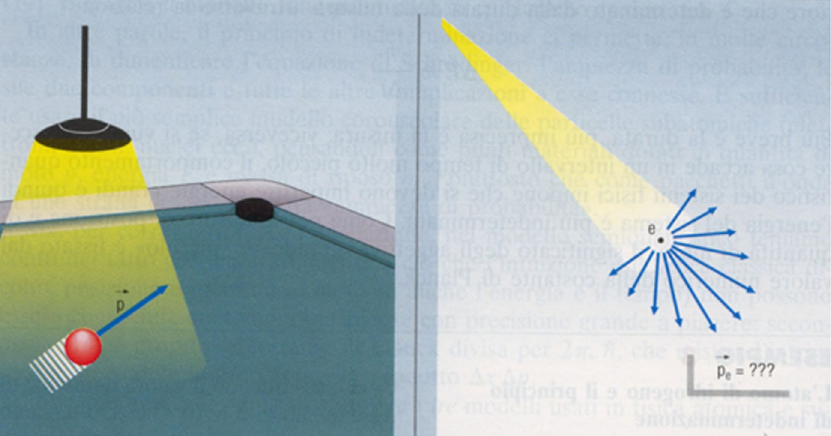
FIG. 6. Depiction of the uncertainty principle from the Heisenberg microscope perspective (reproduced from Ref. [53]).